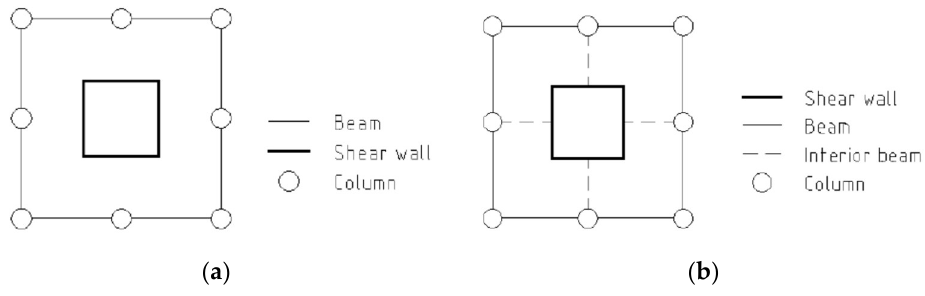
Figure 2. ( a ) Plan view of shear-wall system, ( b ) Plan view of shear wall and frame system. Source: [12].